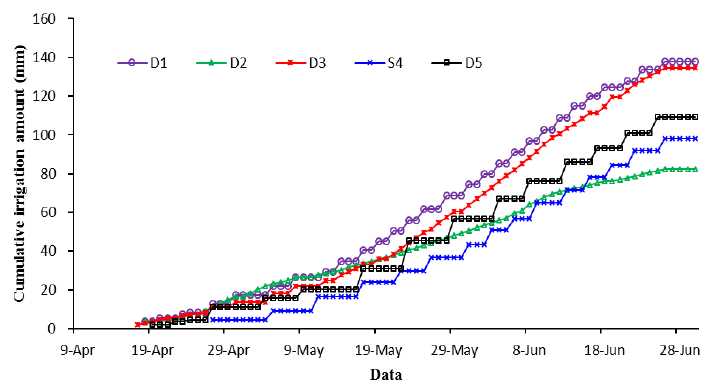
Figure 4. Cumulative irrigation levels for the five treatments.